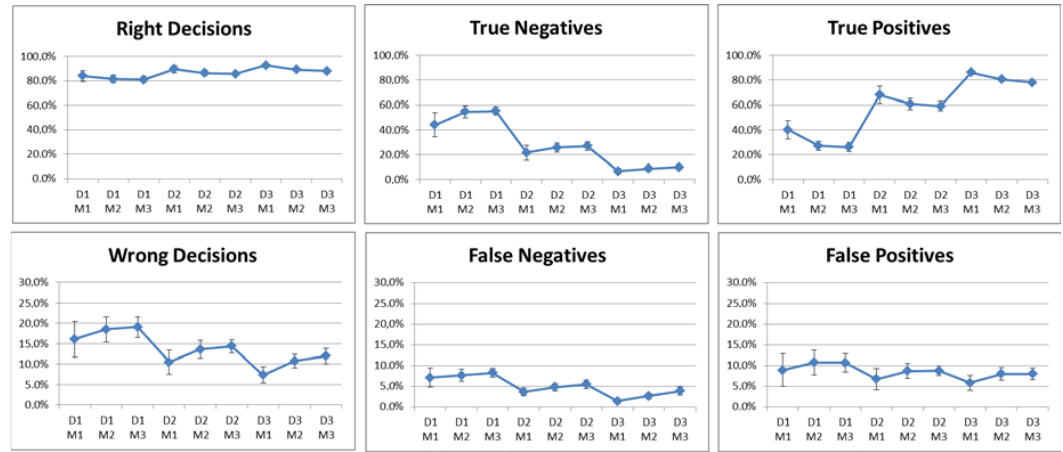
Figure 14. Betrayal attack for Manhattan-Grid Scenario experiments.